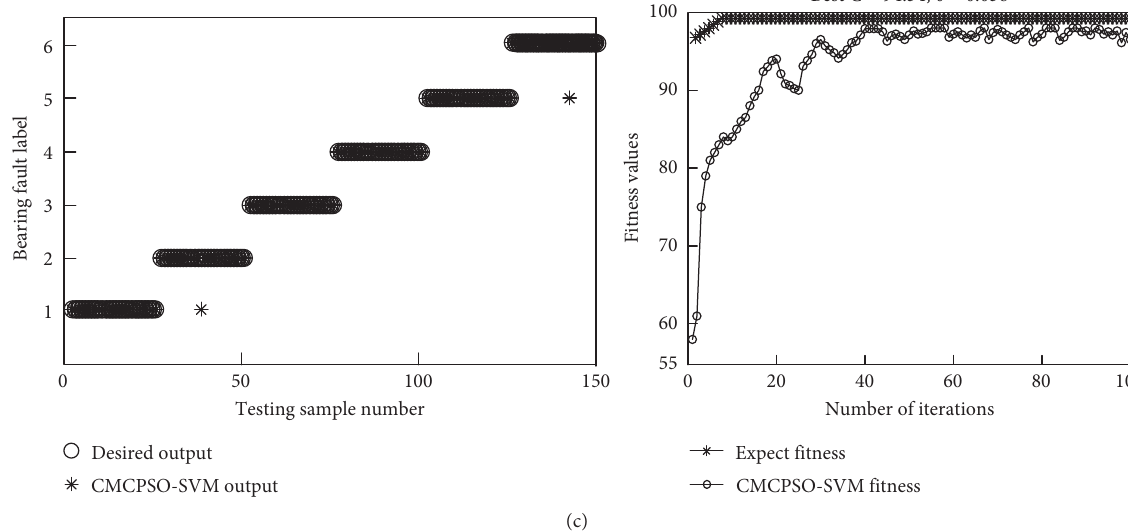
Figure 7: : The classification results and the change law of fitness value. (a) ∼ (c) are the classification results and the change law of